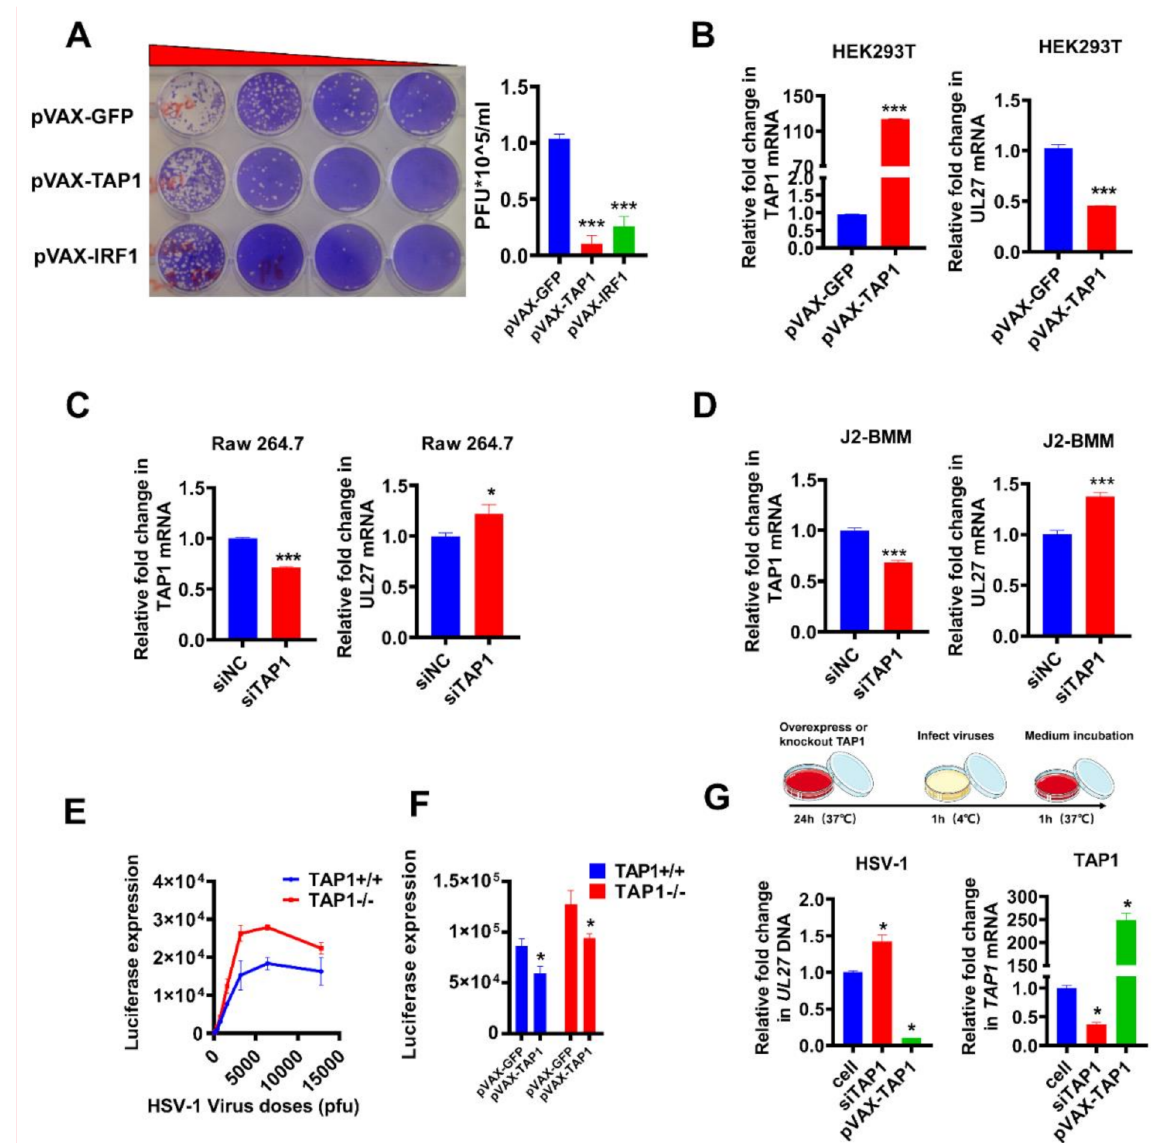
Figure 3. Validation of viral inhibition by loss-of-function and gain-of-function experiments. ( A )Vero cells were transfected with plasmids (1 µ g/mL) expressing GFP , TAP1 , and IRF1 for 24 h, respectively, followed by HSV-1 infection (MOI = 0.25) for 8 h. Then, the titer of HSV-1 in the supernatant was quantified by plaque assay. ( B ) HEK293T cells were transfected with plasmids (1 µ g/mL) expressing GFP and TAP1 for 24 h, respectively, followed by HSV-1 infection (MOI = 0.25) for 8 h. Then, the expression of TAP1 and HSV-1 UL27 were quantified by RT-qPCR. ( C , D) Raw 264.7 and WT-J2-BMM cells were transfected with small interfering RNA (siRNA) (siNC as negative control) for 24 h, followed by HSV-1 infection (MOI = 0.25) for 8 h. Then, the expression of TAP1 and HSV-1 UL27 were quantified by RT-qPCR. The expression level of mRNA was normalized to the expression of β -actin . ( E ) TAP1 -wildtype ( TAP1 +/+) or TAP1 -knockout ( TAP1 − / − ) fibroblast cells were infected with HSV-1, and subsequently, the Renilla luciferase activity in cell lysates was determined at 8 h post infection. ( F ) TAP1 +/+ or T TAP1 − / − fibroblast cells were transfected with or without TAP1 -expressing plasmid (1 µ g/mL) for 24 h, followed by HSV-1 infection (MOI = 0.25) for 8 h, and then the Renilla luciferase activity in cell lysates was determined. ( G ) HEK293 cells were transfected with plasmids (1 µ g/mL) expressing TAP1 or si TAP1 for 24 h, respectively, followed by HSV-1 incubation (MOI = 1) for 1 h at 4 ◦ C. Then, aspirated and discarded the supernatant, washed with PBS three times, added culture medium, incubated at 37 ◦ C for 1 h, and the expression of HSV-1 ( UL27 ) and TAP1 were quantified by qPCR. The expression level was normalized to the expression of β -actin, and the data from at least triplicates were shown as the mean ± SD. * p < 0.05, and *** p <